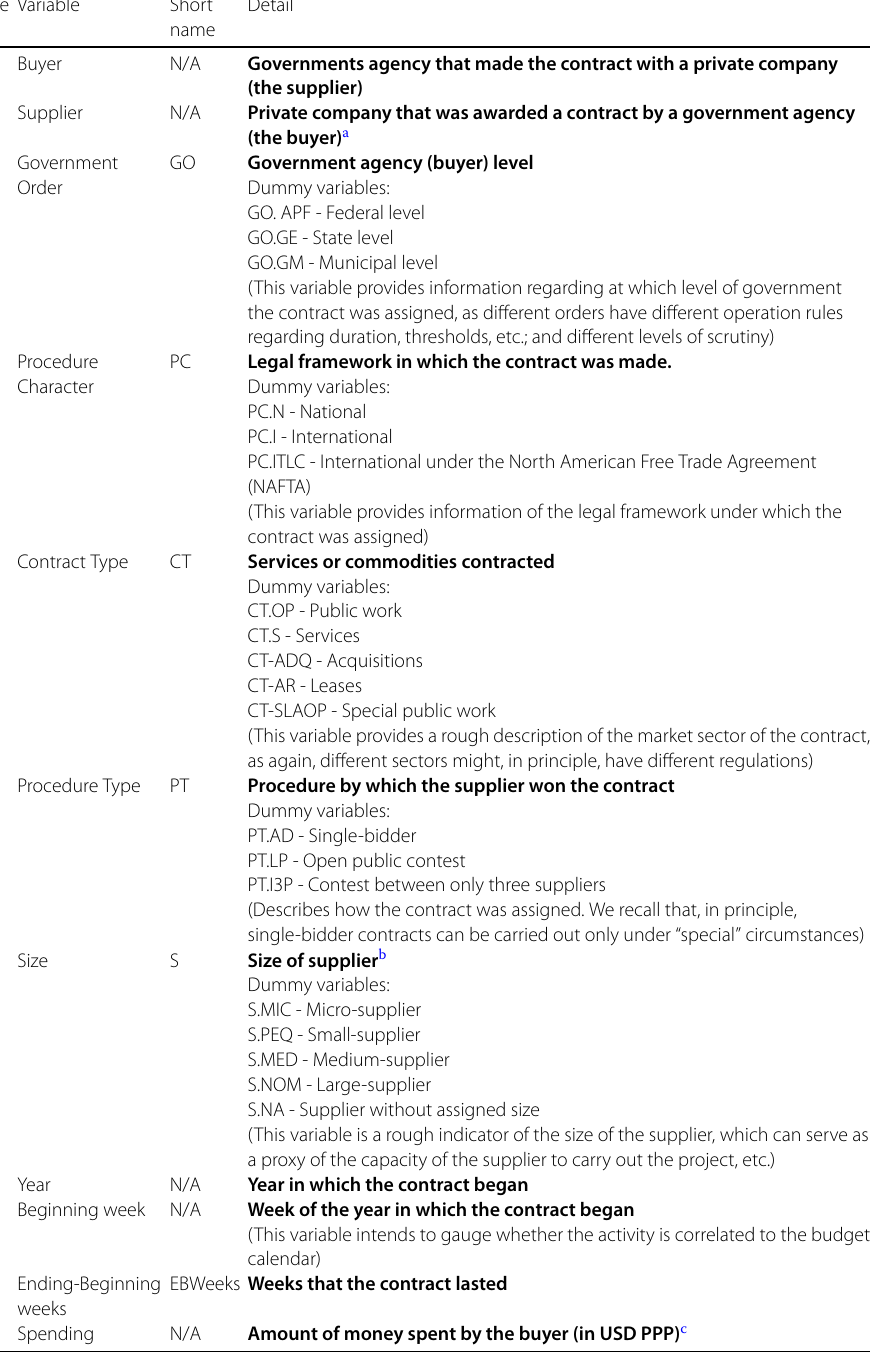
Table 1 Set of the variables chosen to describe the features of each contract from the source list of public contracts [24]. In parenthesis, a short explanation of the variables that are not self explanatory is given, providing the motivation for considering each particular